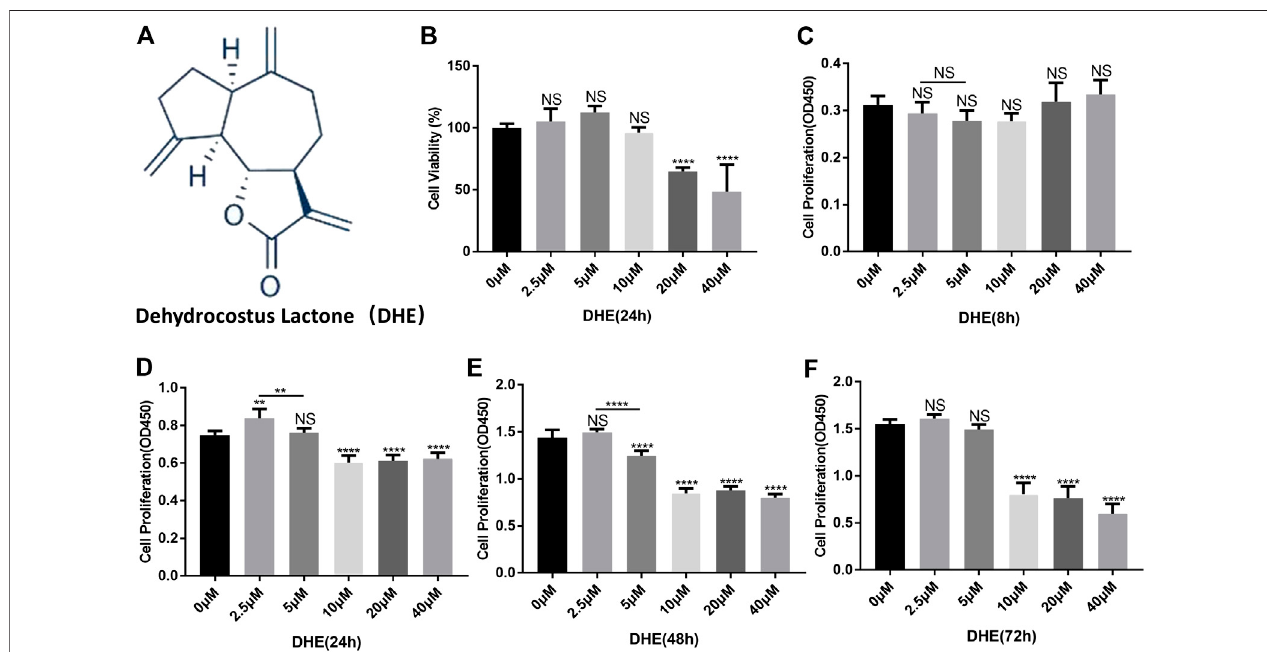
FIGURE1 | Effects ofdehydrocostuslactone (DHE) on the cytotoxicity and proliferation ofnucleus pulposus ( NP) cells. (A) The chemical structure of DHE. (B) The cellcountingkit-8 ( CCK-8)assaymeasuredeffectsoftheindicatedconcentrationsofDHEonthetoxicityofNPcellsat24 h.The96-wellplatescontained8,000NPcells per well. Data are presented as the mean ± SEM. n (cid:2) 3. **** p < 0.0001 relative to the control group. (C – F) Effects of the indicated concentrations of DHE on the proliferation of NP cells at 8, 24, 48, and 72 h, as measured by the CCK-8 assay. The 96-well plates contained 2,000 NP cells per well. Data are presented as the mean ± SEM. n (cid:2) 3. ** p < 0.01, **** p < 0.0001 relative to the control